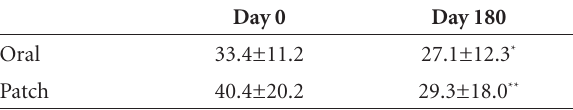
Table 2. Neuropsychiatric inventory evaluation at two time points.